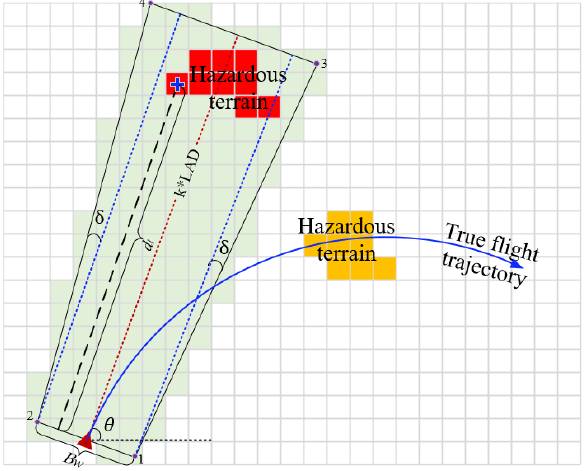
Figure 3. Trapezoidal boundary. 133